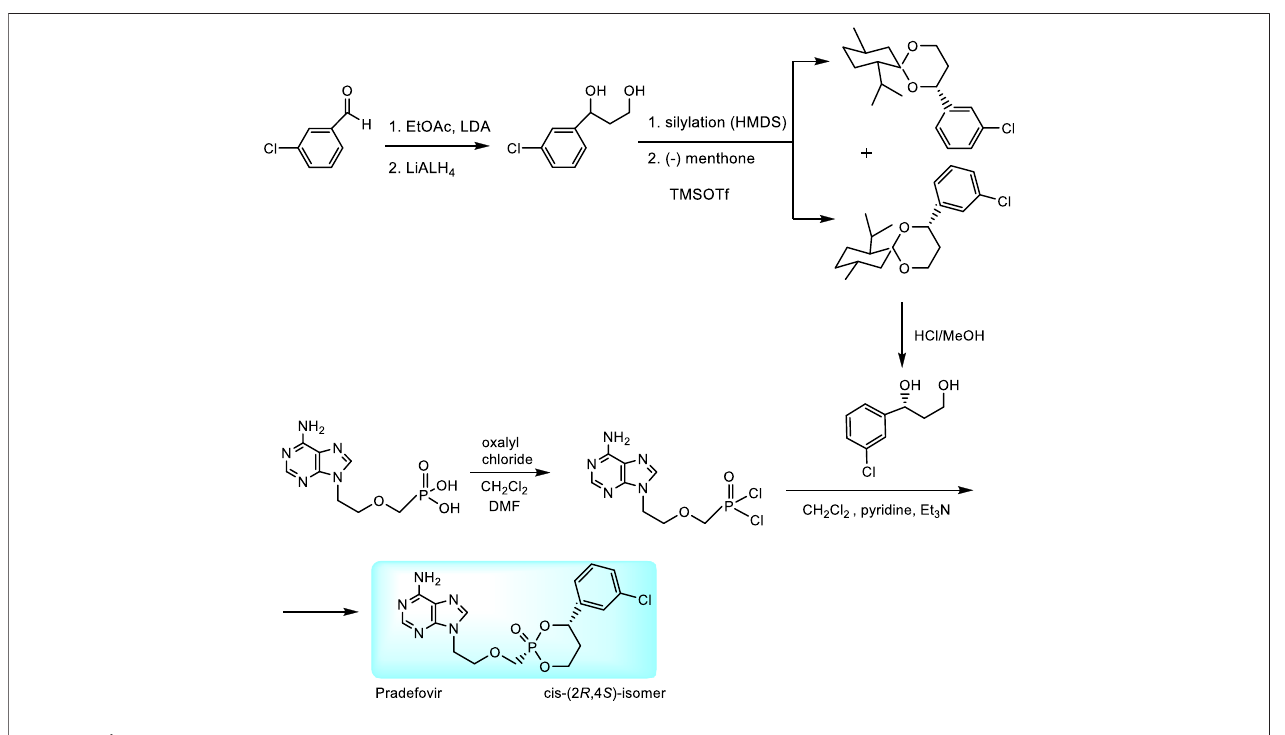
FIGURE 6 | Synthesis of